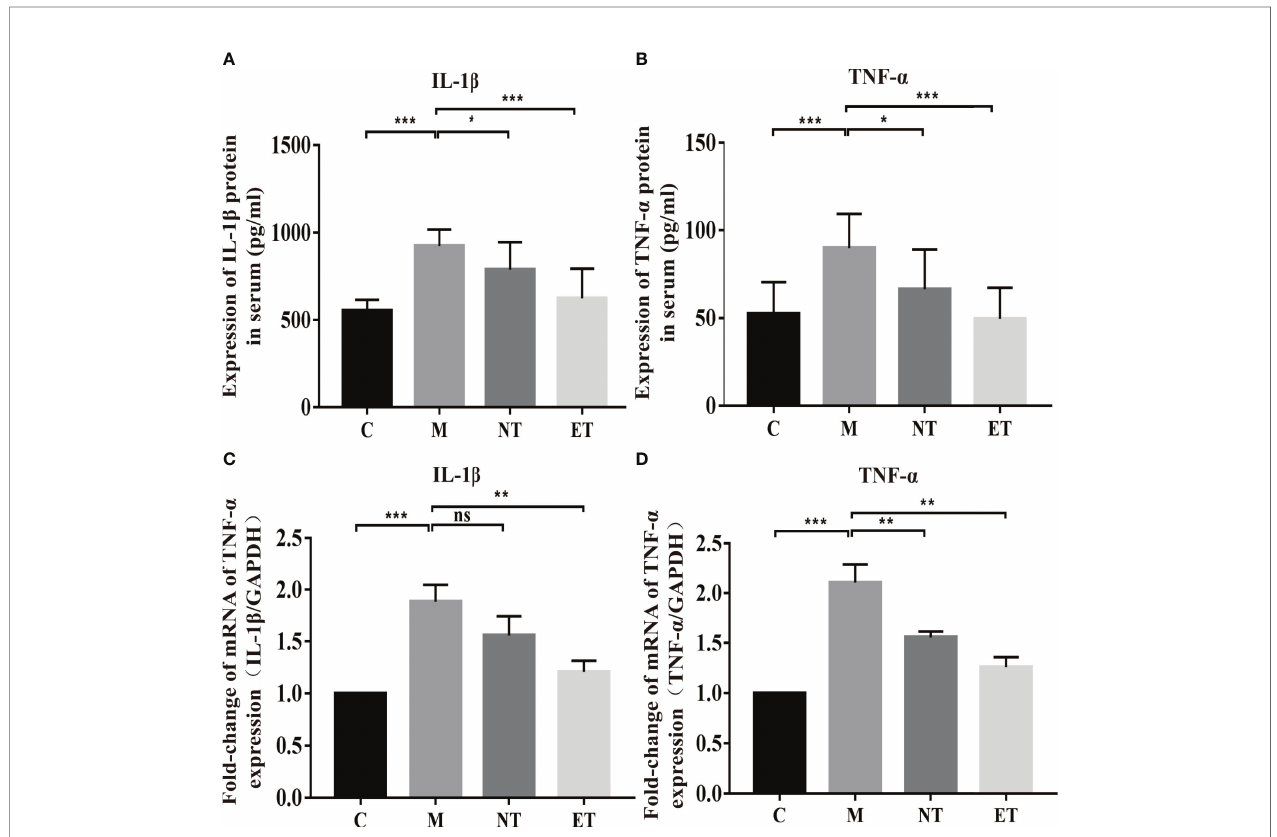
FIGURE 2 | Effects of L. crispatus -pMG36e-mCXCL12 on the expression of pro-in fl ammatory factors at the protein and gene levels in intrauterine adhesion mice. Effect of L. crispatus -pMG36e-mCXCL12 on the expression of IL-1 b (A) and TNF- a (B) in the uterine tissue of intrauterine adhesion mice at the protein level. Effect of L. crispatus -pMG36e-mCXCL12 on the expression of IL-1 b (C) and TNF- a (D) in the uterine tissue of intrauterine adhesion mice at the gene level. C group, Control group; M group, laparotomy was used to construct a model of intrauterine adhesion; NT group was treated with L. crispatus for intrauterine adhesion mice; ET group was treated with L. crispatus -pMG36e-mCXCL12 for intrauterine adhesion mice. Unpaired t-test was used for statistical analysis and all data are presented as mean ± standard deviation (SD). ns, P > 0.05; *P < 0.05; **P < 0.01; ***P <